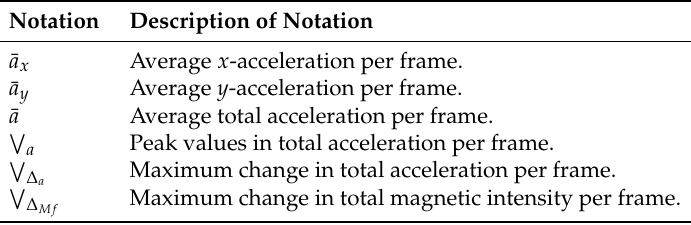
Table 3. Summary of the features selected after RFE.